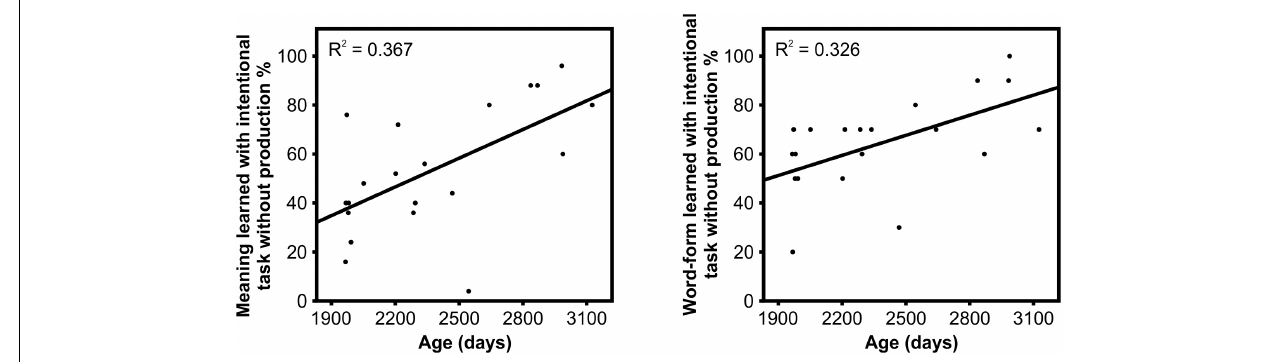
FIGURE 3 | Correlations between age and learning the meanings (left) and correct word forms (right) for the intentional task without production.